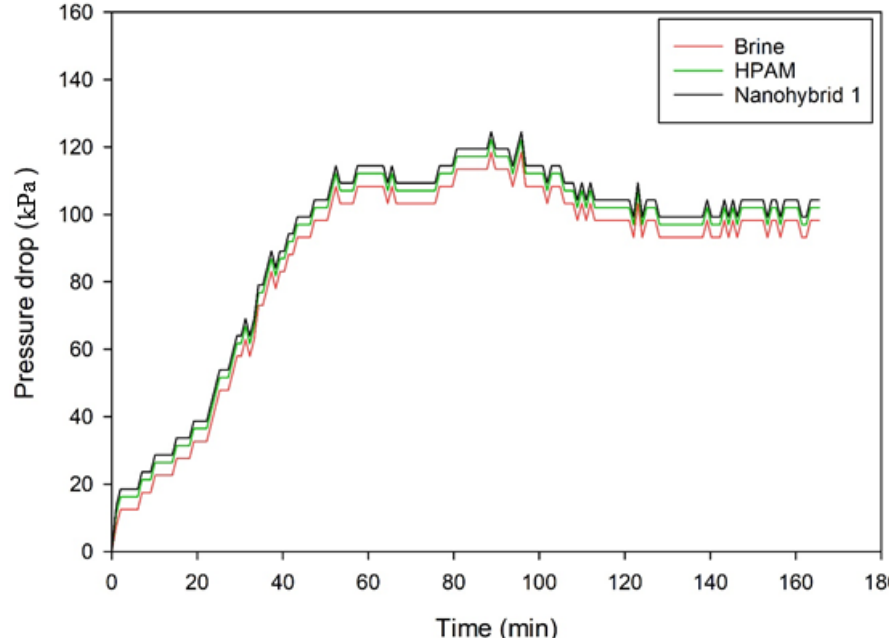
Figure 10. Pressure drop while saturating the sandpacks with oil during sandpack preparation. Shear rate = 10 s − 1 , T = 85 °C. Table 4. Stability criterion results for brine, HPAM polymer solution, and nanohybrid 1 flooding.